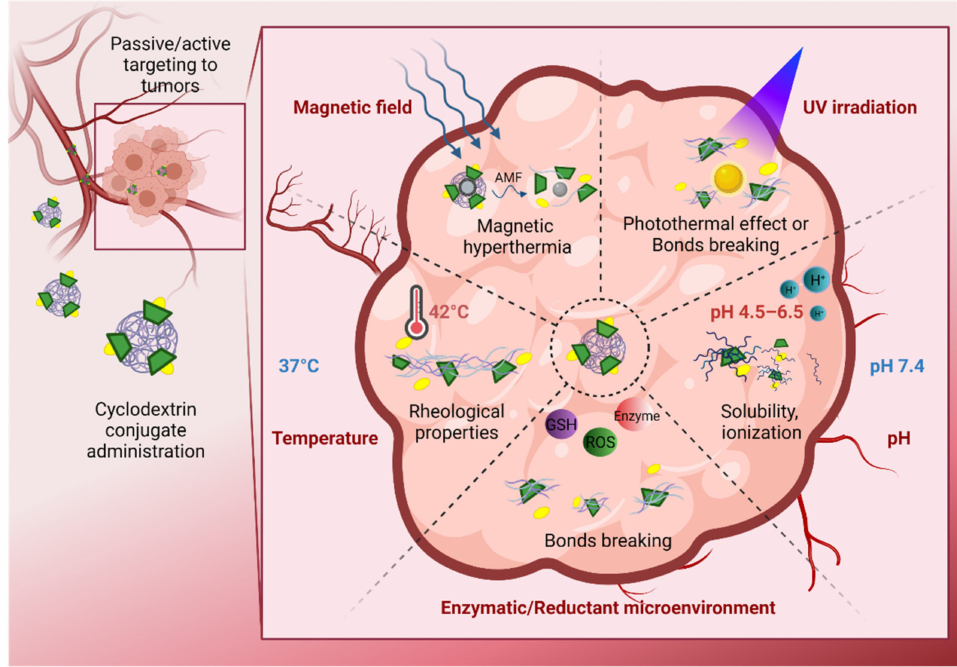
Figure 4. Stimuli-controlled drug release from CD-modified nanomaterials in tumor sites. The conjugates reach the tumor sites by passive/active targeting, then an external stimulus (alternating magnetic field, AMF, or UV irradiation) and/or an internal stimulus (temperature, intracellular metabolites, or acidic pH) triggers the drug release from the conjugates. Created with